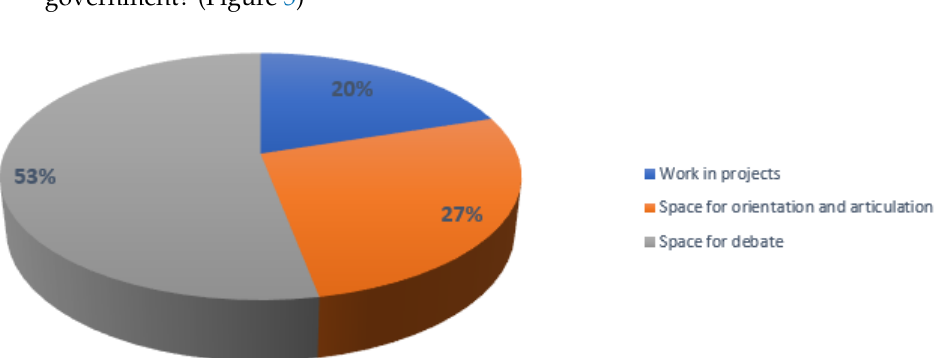
Figure 5. Role to be played with the local government. Source: Research data 2019-authors.